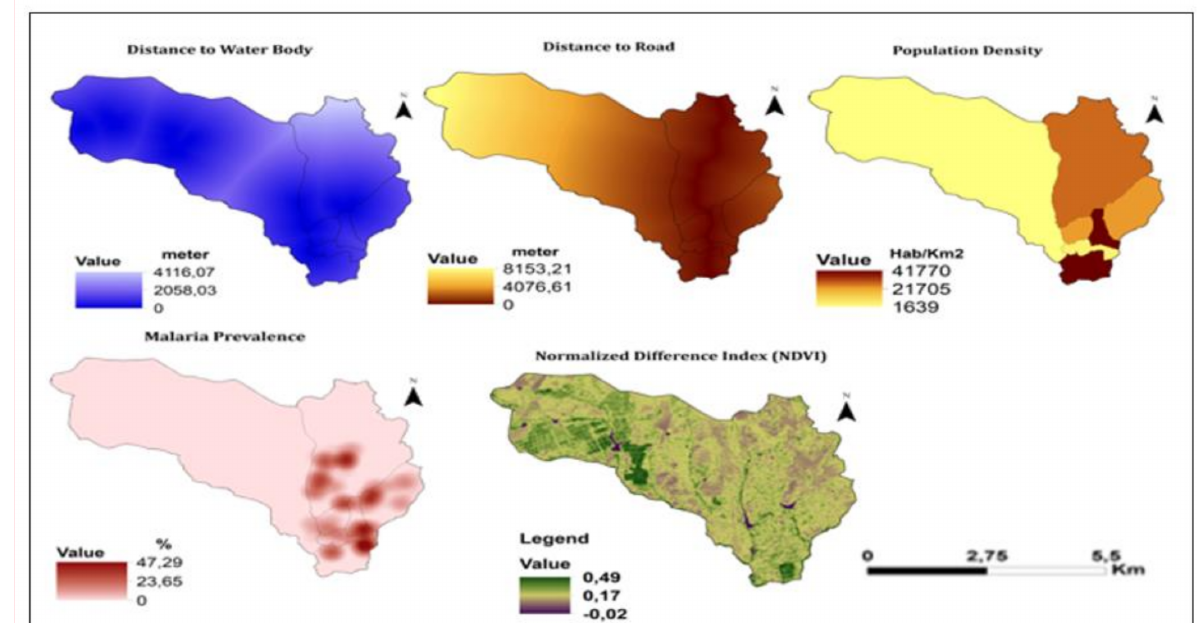
Figure 7. Maps of water bodies (DTWB). distance to the road (DTR). population density (PD). malaria point prevalence (MPP) and normalized difference index (NDVI) in Sussundenga